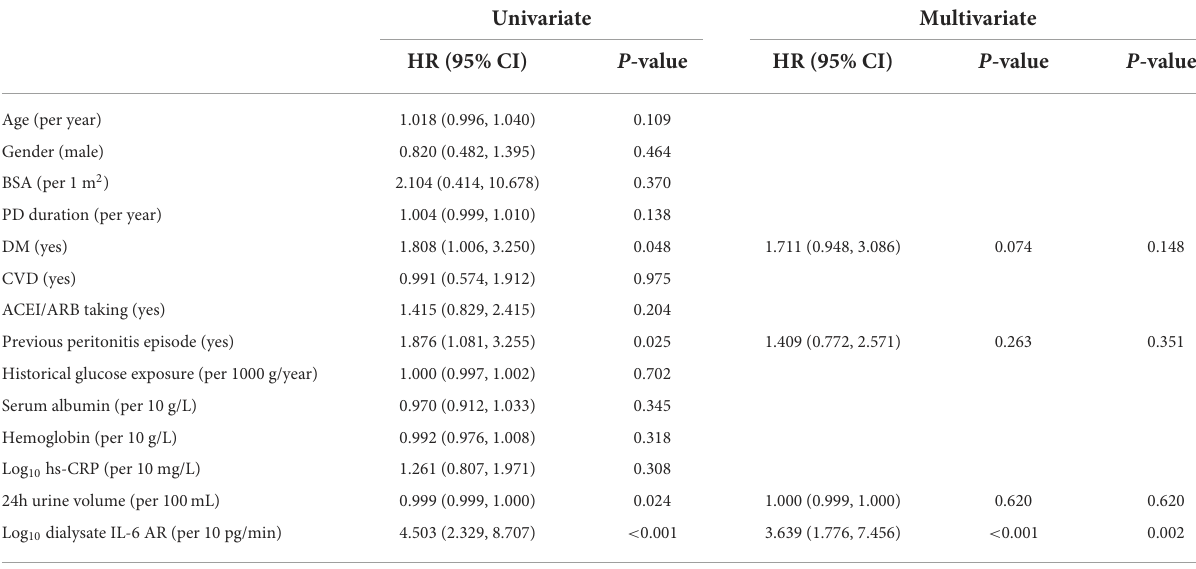
TABLE 5 Predictors of UF insufficiency on Cox regression